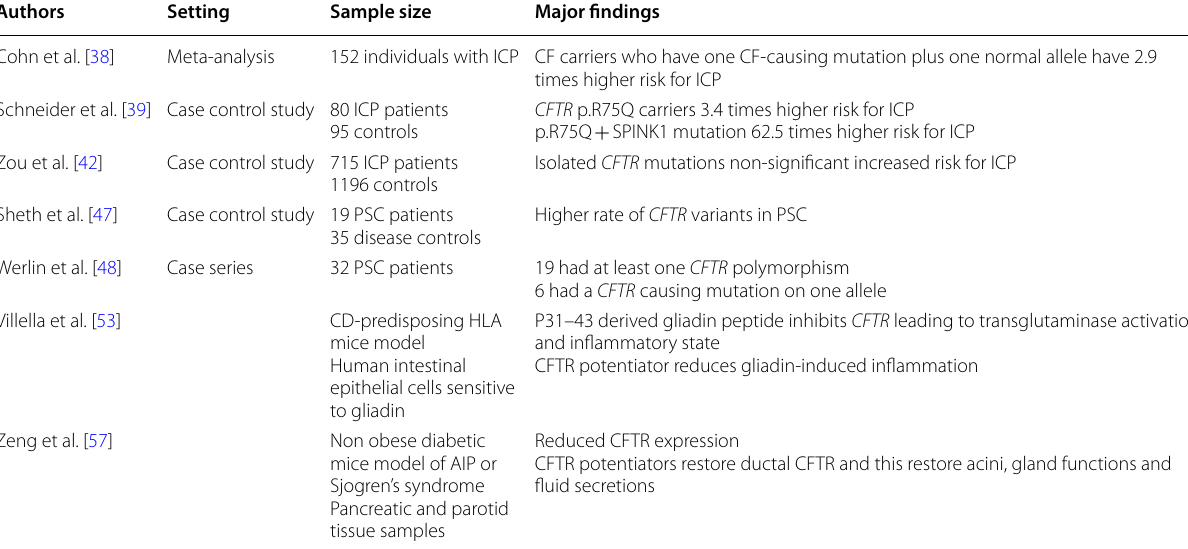
Table 2 Summary of main studies about CFTR and gastrointestinal disorders